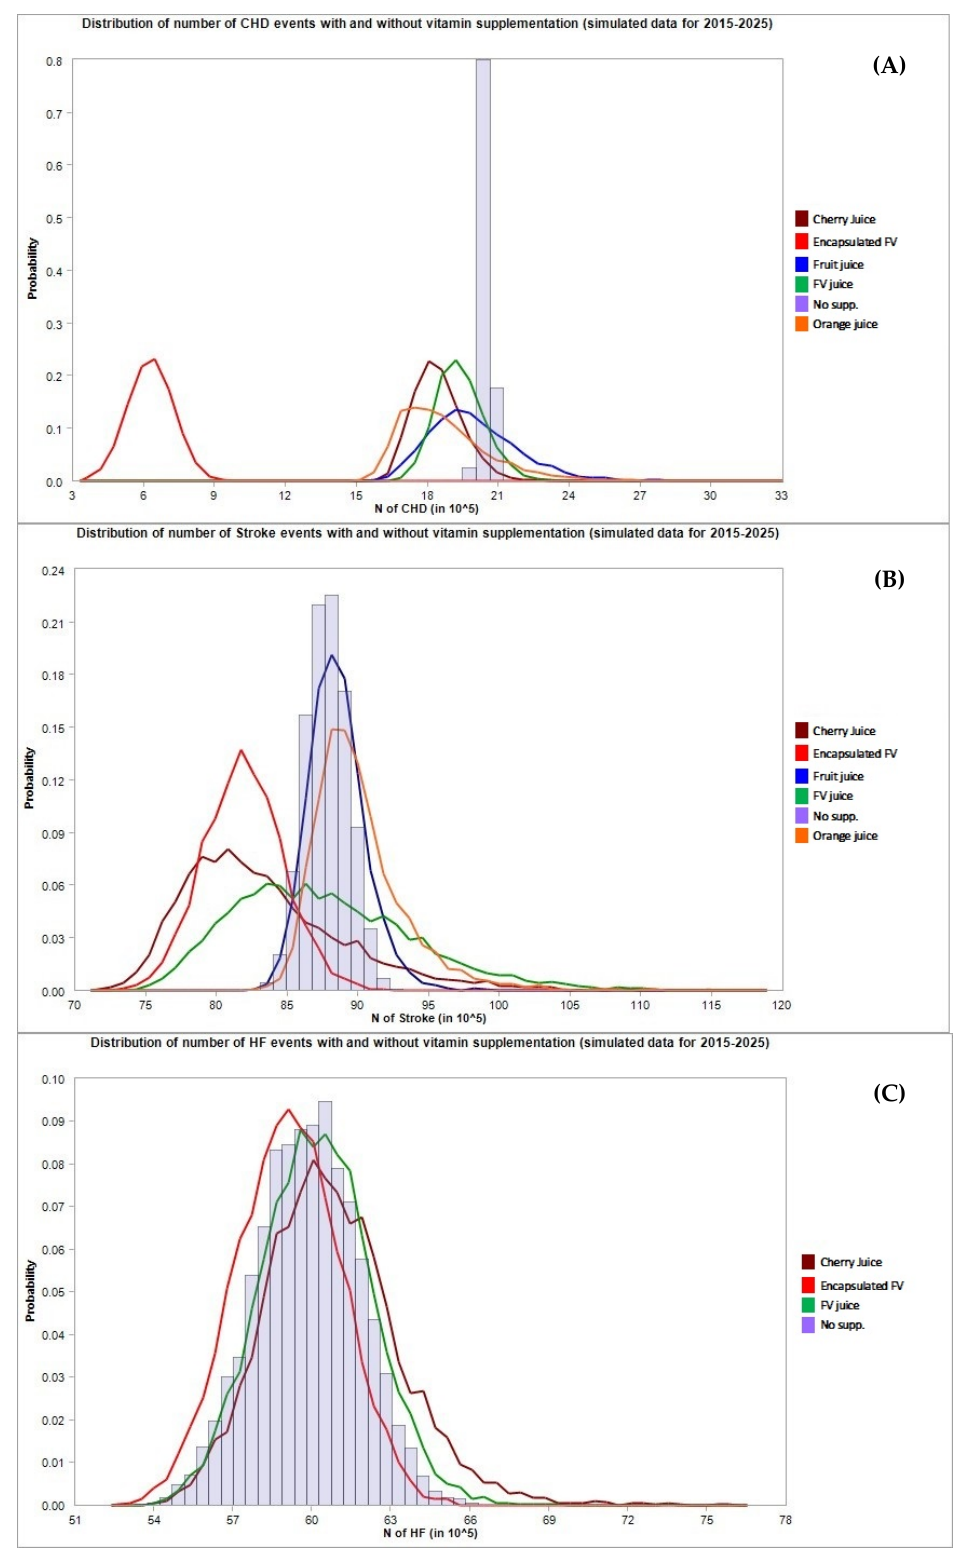
Figure 2. Number of cardiovascular events avoided under different supplementation regimes (estimates for the general population). The first chart ( A ) refers to CHD cases, the second chart ( B ) refers to stroke cases, the third chart ( C ) refers to HF cases.